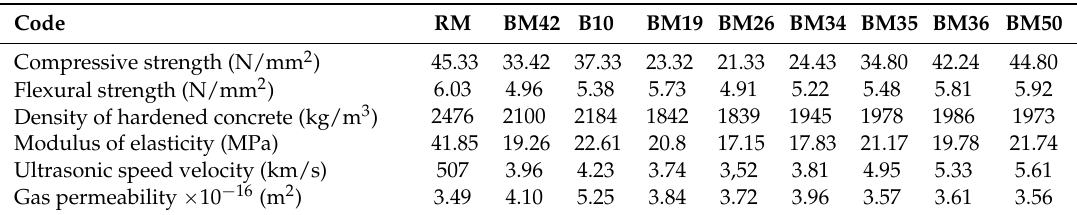
Table 5. Properties of 56-day-old hardened